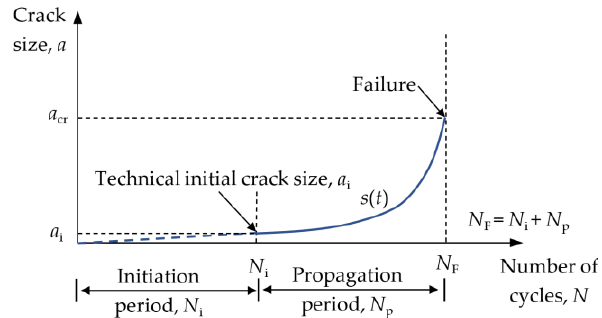
Figure 3. Crack size in relation to a number of stress cycles.